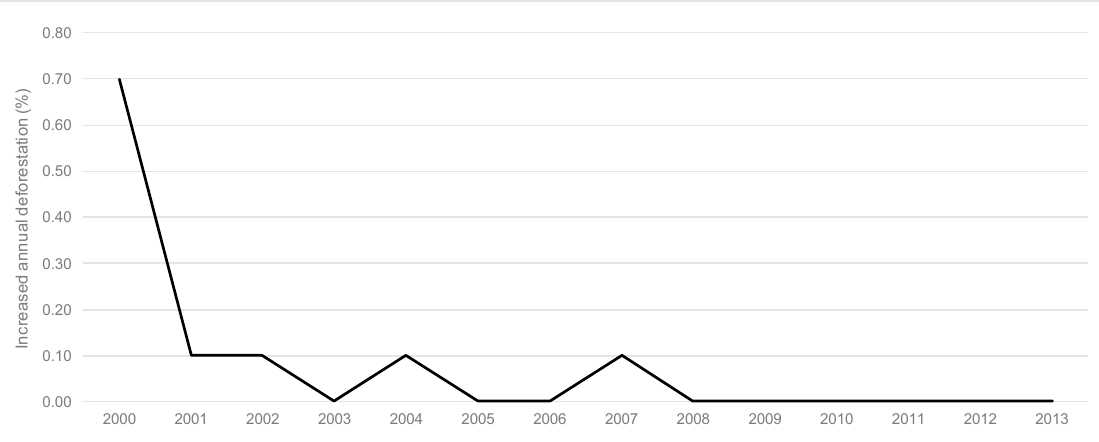
Figure 4. Increased annual deforestation in Tapaj ó s National Forest between 2000 and 2013 (Adapted from